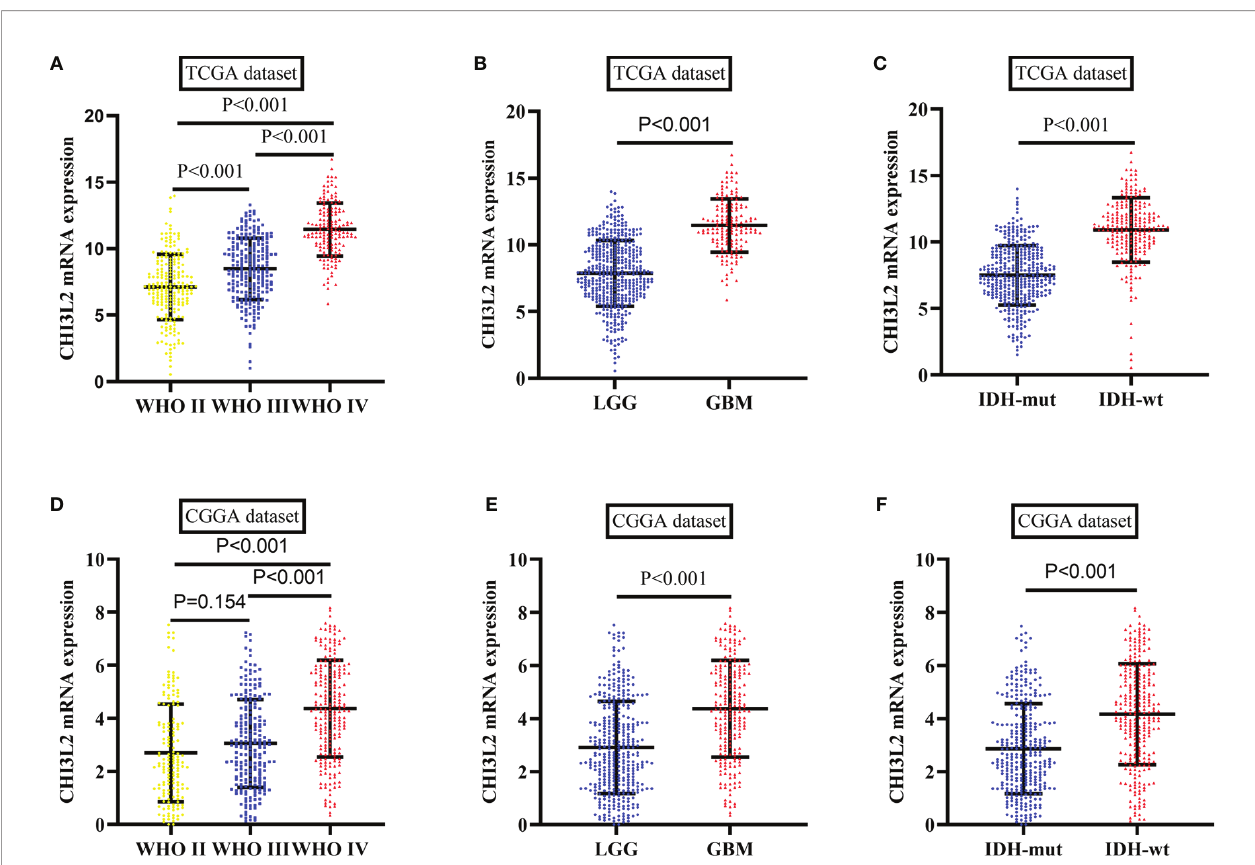
FIGURE 4 | The mRNA expression levels of CHI3L2 in gliomas in TCGA and CGGA datasets. (A) CHI3L2 mRNA levels in diffusely in fi ltrating glioma (WHO II-IV) in the TCGA dataset. (B) CHI3L2 mRNA levels in LGG and GBM in TCGA dataset. (C) CHI3L2 mRNA levels in diffusely in fi ltrating glioma with different IDH status in TCGA dataset. (D) CHI3L2 mRNA levels in diffusely in fi ltrating glioma (WHO II-IV) in the CGGA dataset. (E) CHI3L2 mRNA levels in LGG and GBM in CGGA dataset. (F) CHI3L2 mRNA levels in diffusely in fi ltrating glioma with different IDH status in CGGA dataset.